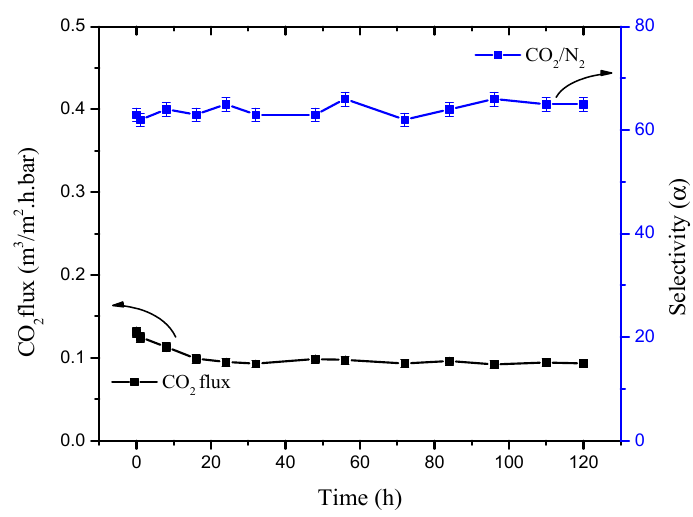
Figure 11. Long-term operation test for permeability of CO 2 and N 2 gas and the paired gas selectivity for PAN- r -PEGMA67 composite membrane. Gas permeation tests were conducted at 25 °C and 0.5 bar.